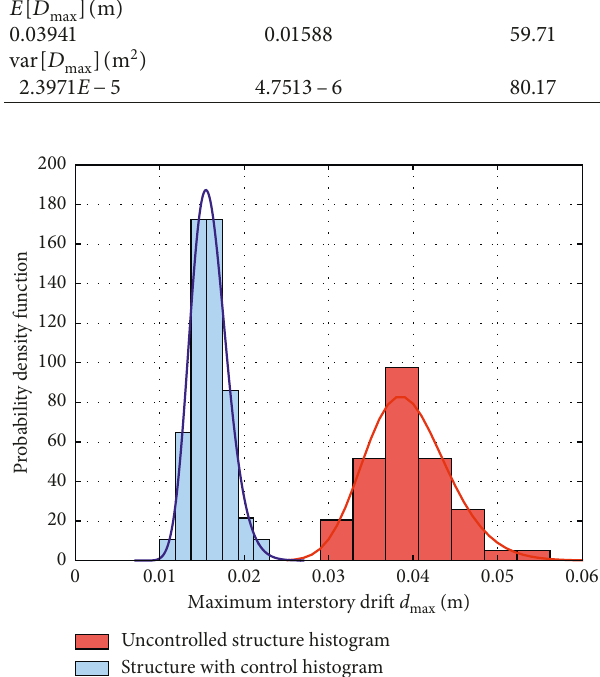
Figure 2: Probability density function of maximum interstory drift d for uncontrolled structure (red curve) and with control (blue max